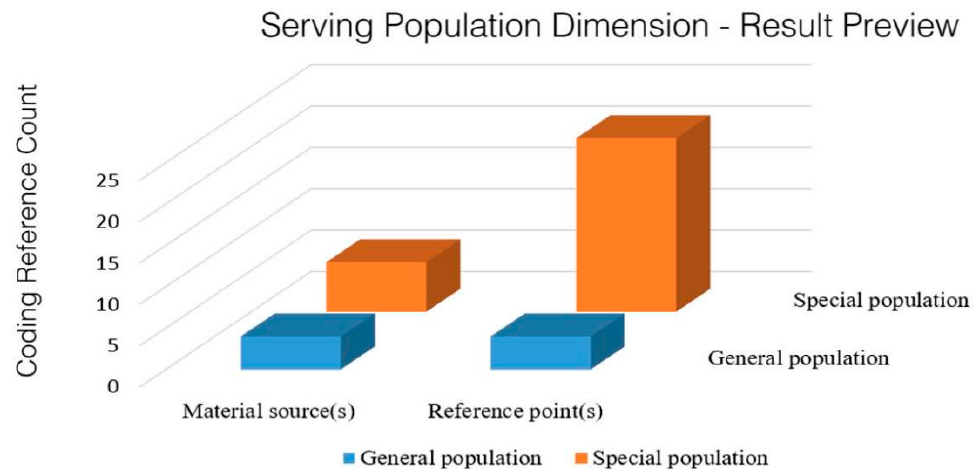
Figure 3. Distribution of reference points for the population served by the integration of the sports and medicine policy.